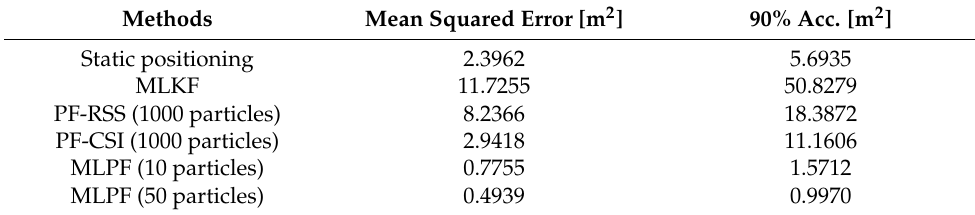
Figure 8. Tracking result of MLPF with 10 and 50 particles in the office rooms. Table 2. Positioning Error (office